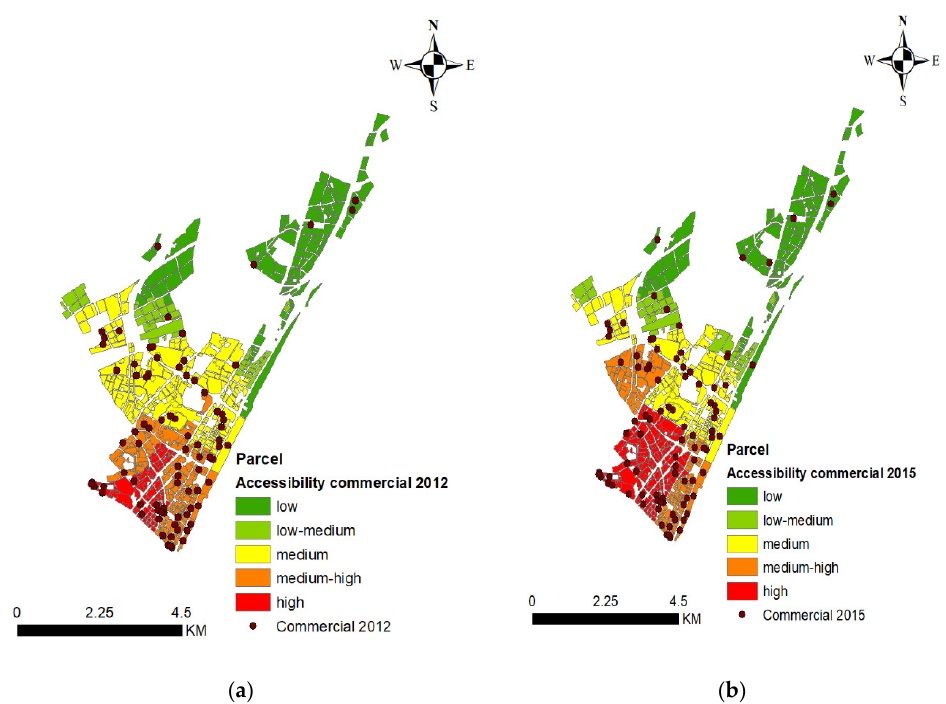
Figure 10. ( a , b ) Accessibility to commercial activities and commercial space developed at parcels level: ( a ) Accessibility to commercial activities (2012); and ( b ) Accessibility to commercial activities